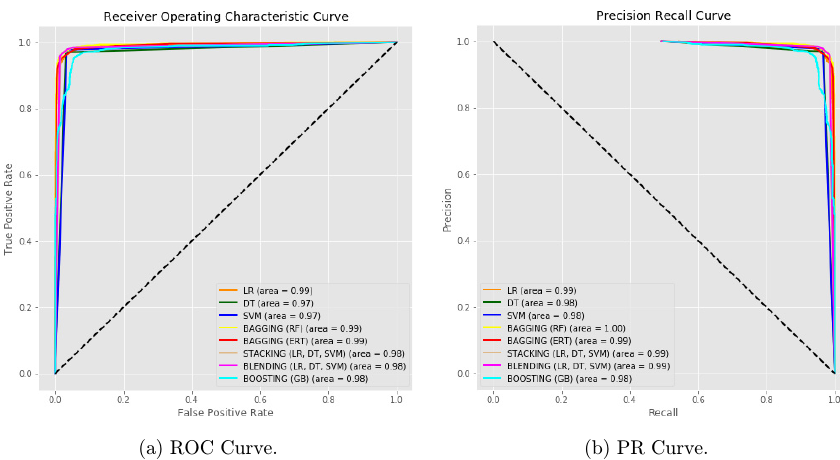
(d) Accuracy (Scatter Plot). Fig. 3. Two words as Substring (model 2).